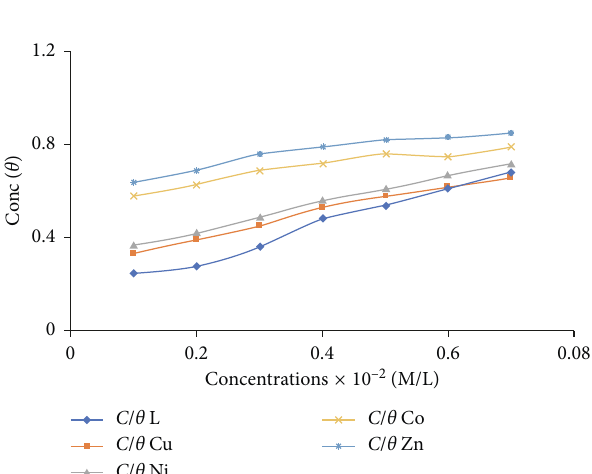
Figure 11: Langmuir adsorption isotherms of the mixed ligands (L) and their metal